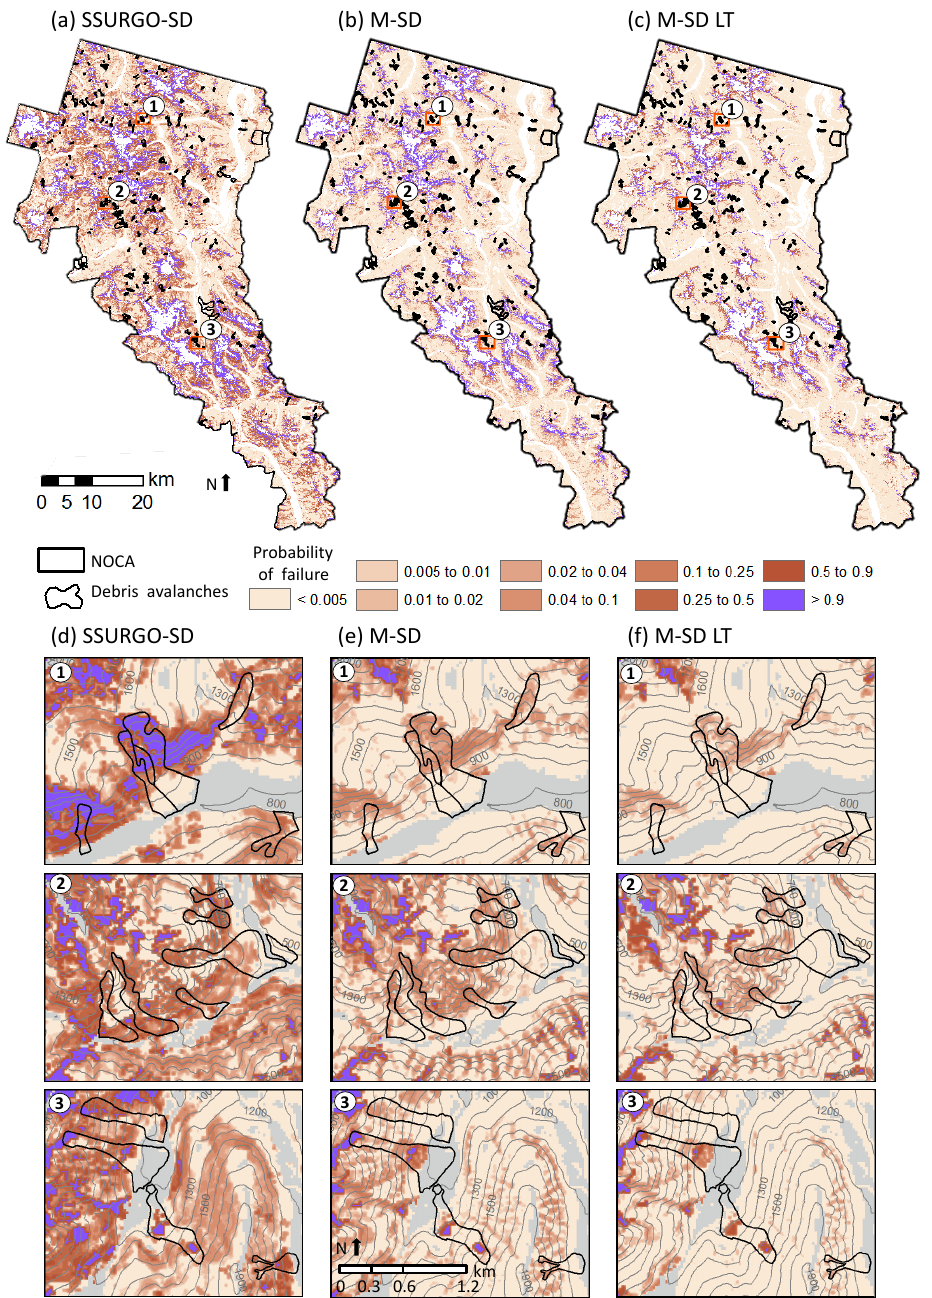
Figure 8. Landslide annual P ( F ) map for NOCA overlain with mapped debris avalanches for simulations with (a) SSURGO-SD, (b) M-SD, and (c) M-SD LT. Zoomed-in areas are shown for greater detail in the lower panel in the same order and according to number designated. Purple areas are considered chronically unstable and areas excluded from analysis are shown as gray. Contours are at 100m. Aerial images of zoomed-in areas are provided in Fig.